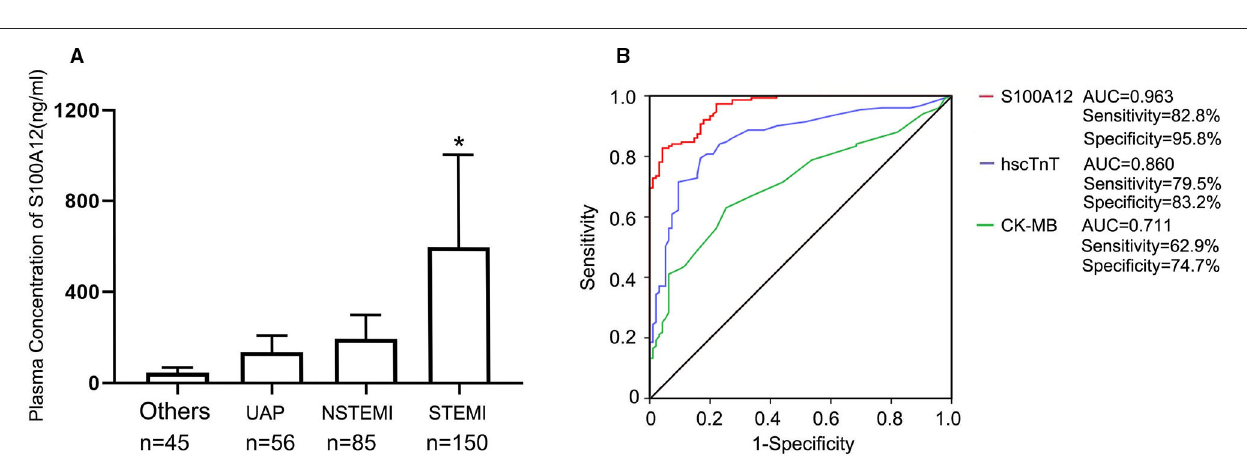
risk of all-cause death (4.2 vs. 2.4 vs. 0.9%, P trend = 0.03) ( Table 3 ). By univariable analysis advanced age, male sex, Killip class, diabetes, history of stroke, treatment with angiotensin- converting enzyme inhibitors (ACEI) and statins at discharge, peak S100A12 level were associated with 1-year MACCE. By multivariable analysis, the peak plasma S100A12 level was an independent predictor of 1-year MACCE (HR 1.001, 95%CI 1.000–1.002; P = 0.01) for all patients with STEMI ( Table 4 ) and those treated with primary PCI (HR 1.001, 95%CI 1.000–1.002, P = 0.01; Supplementary Table S3 ). Peak levels of hscTnT and CK-MB were not significantly associated with 1-year